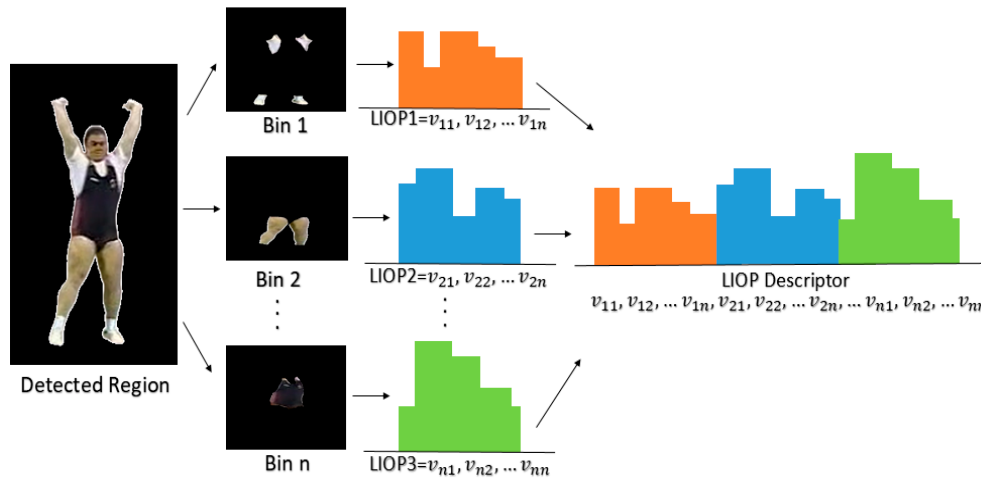
Figure 6. LIOP feature